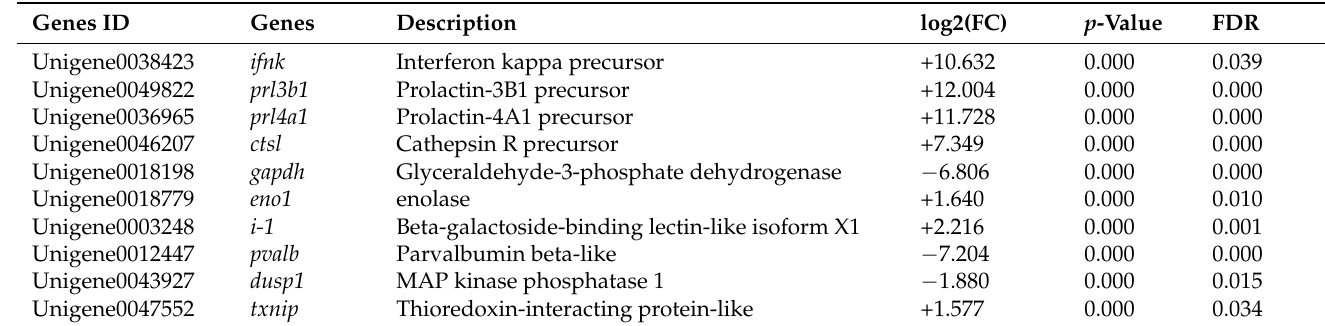
Table 7. Part of the DEGs of SL0 vs L3.